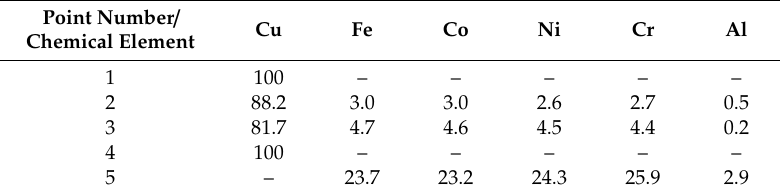
Figure 3. Morphology of the welding interface and a larger view of the corresponding area: ( a , b ) WCH2; ( c , d ) WCH5. Table 2. Chemical composition of corresponding points in Figure 3b (at.%).